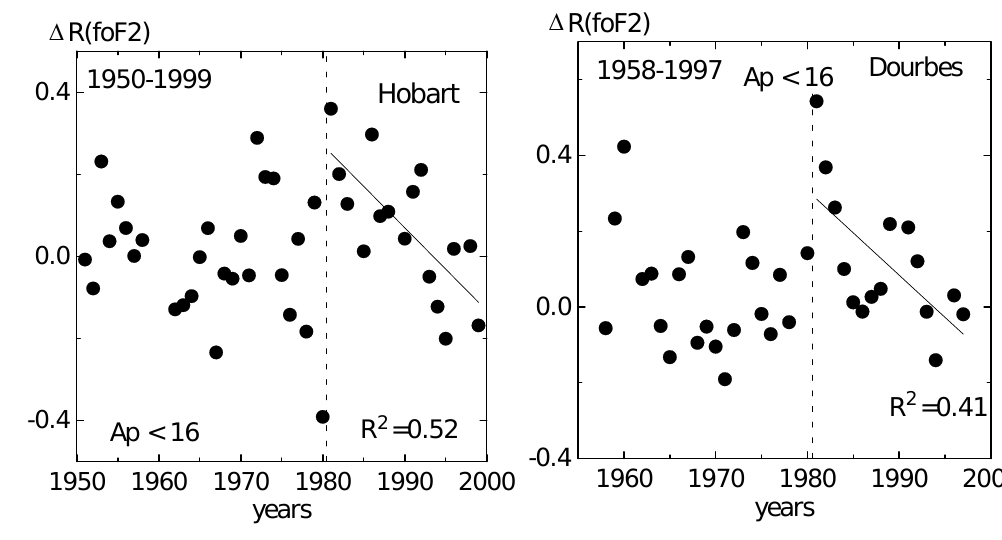
Fig. 4. Variations with time of the 1R ( fo F2) for Hobart and Dourbes.